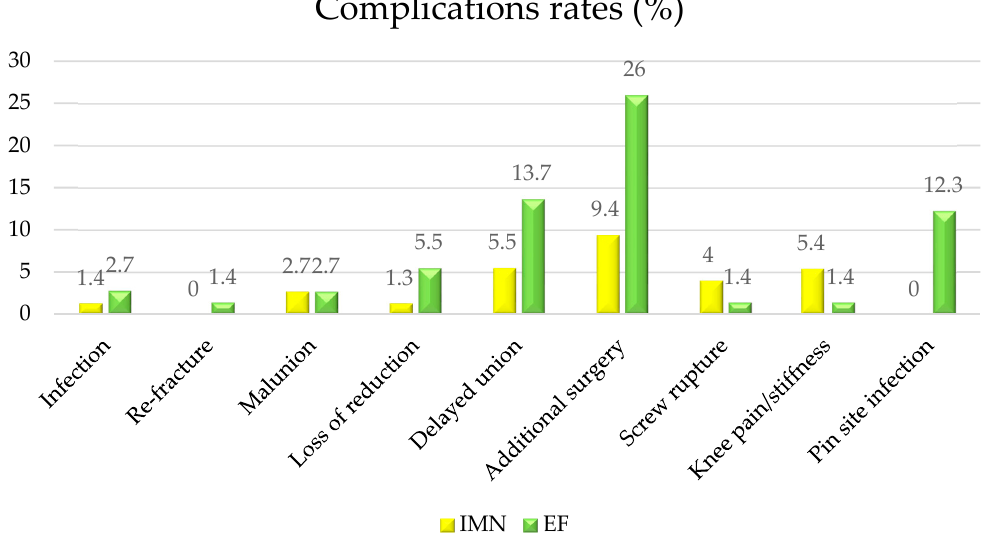
Figure 3. Complications: IMN versus EF group.